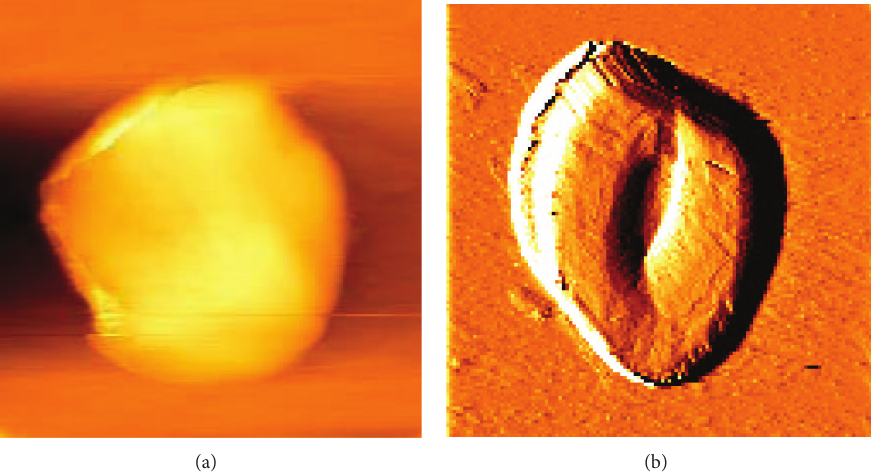
Figure 2: AFM images of urinary crystal of one patient with CaOx calculi before (a) and after (b) K 3 cit intake. Image size: 3 𝜇 m × 3 𝜇 m.